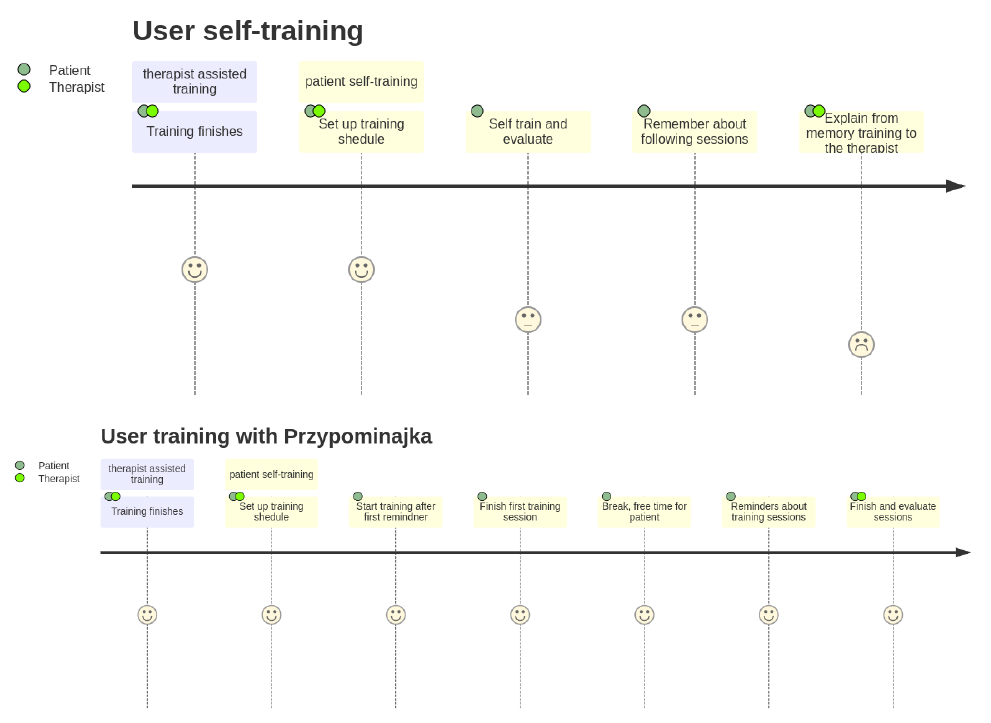
Figure 2. User journeys: with the current self-training scheme and assisted training with Przypomi- najka